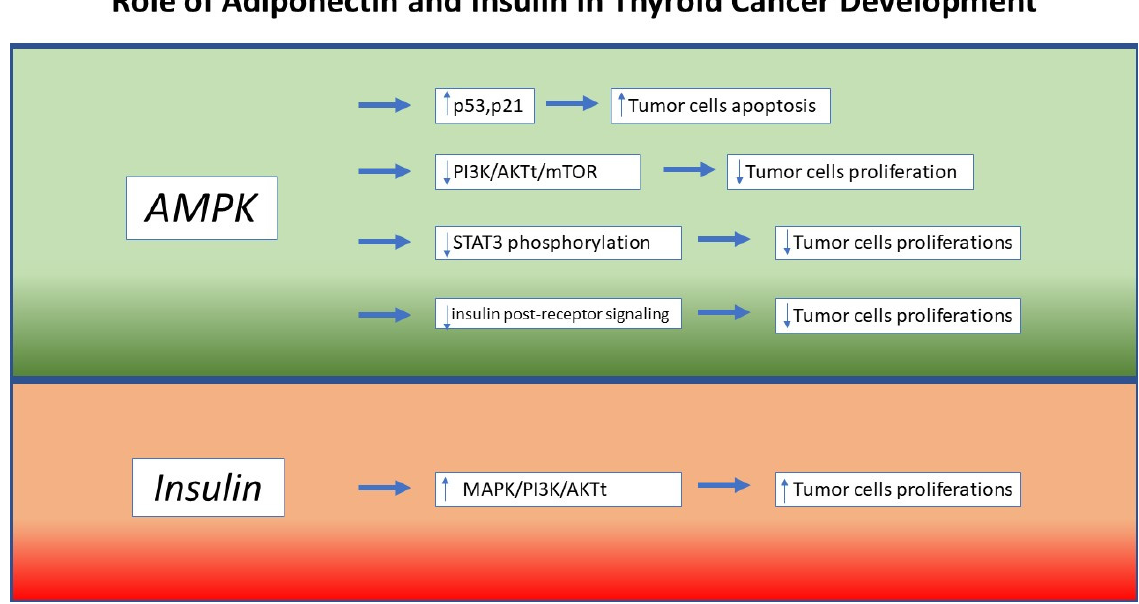
Figure 1. Molecular Mechanisms supporting the relation between obesity and thyroid cancer onset. AMPK: 5’ AMP- activated protein kinase; MAPK: mitogen-activated protein kinase; PI3K: Phosphoinositide 3-kinases; mTOR: mammalian target of rapamycin; STAT3: Signal transducer and activator of transcription 3; AKT: serine/threonine kinase.